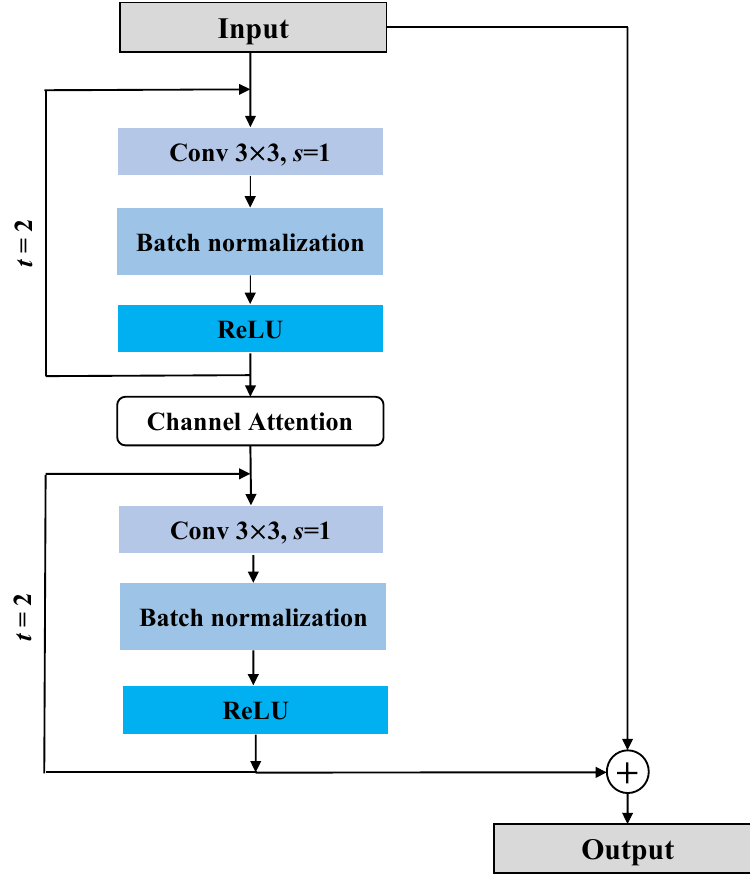
Figure 4. Architecture of the R2CL blocks in the NG-GAN generator. It has two blocks each consisting of 3 × 3 convolutional layers followed by a batch normalization and a ReLU activation layer in each block. The value t = 2 indicates that the recurrent convolution layers are expanded to two-time steps. The output generated by the R2CL unit is given by